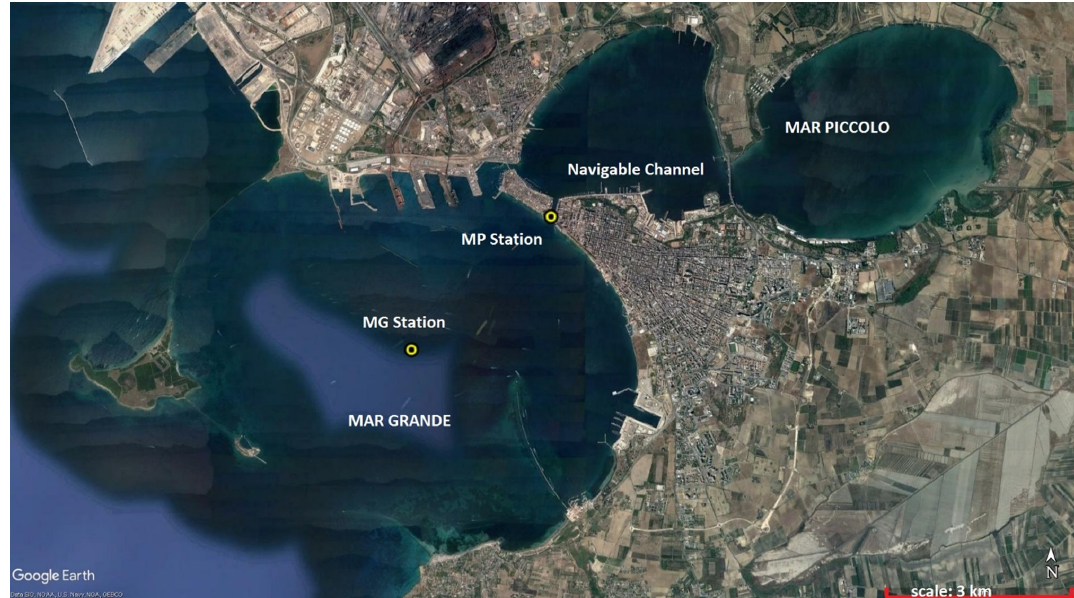
Figure 1. Map of the Mar Grande and Mar Piccolo coastal system, with the location of the two monitoring stations MG and MP. Source: Google Earth.